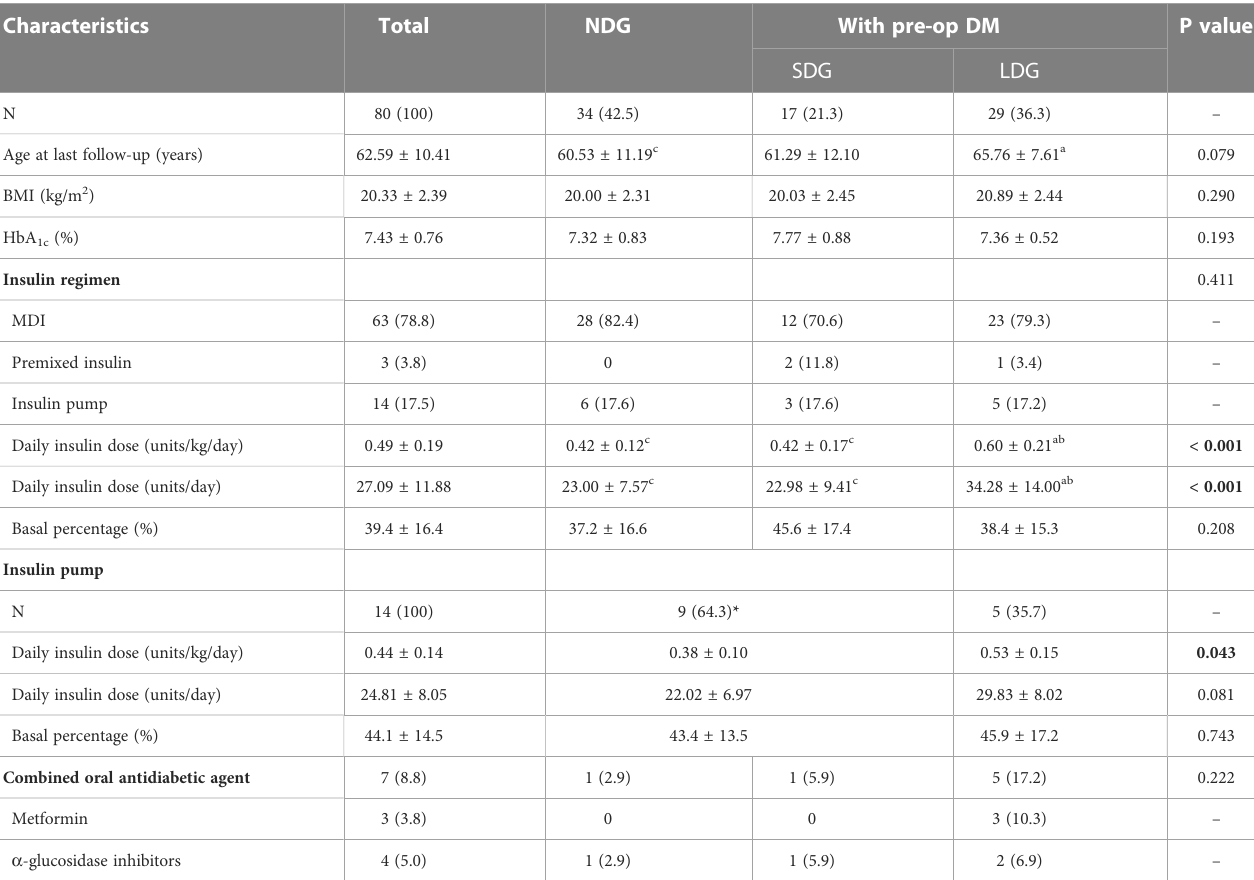
TABLE 4 Glycemic control and treatment of patients undergoing total pancreatectomy in long-term follow-up period categorized by preoperative glycemic status. Characteristics